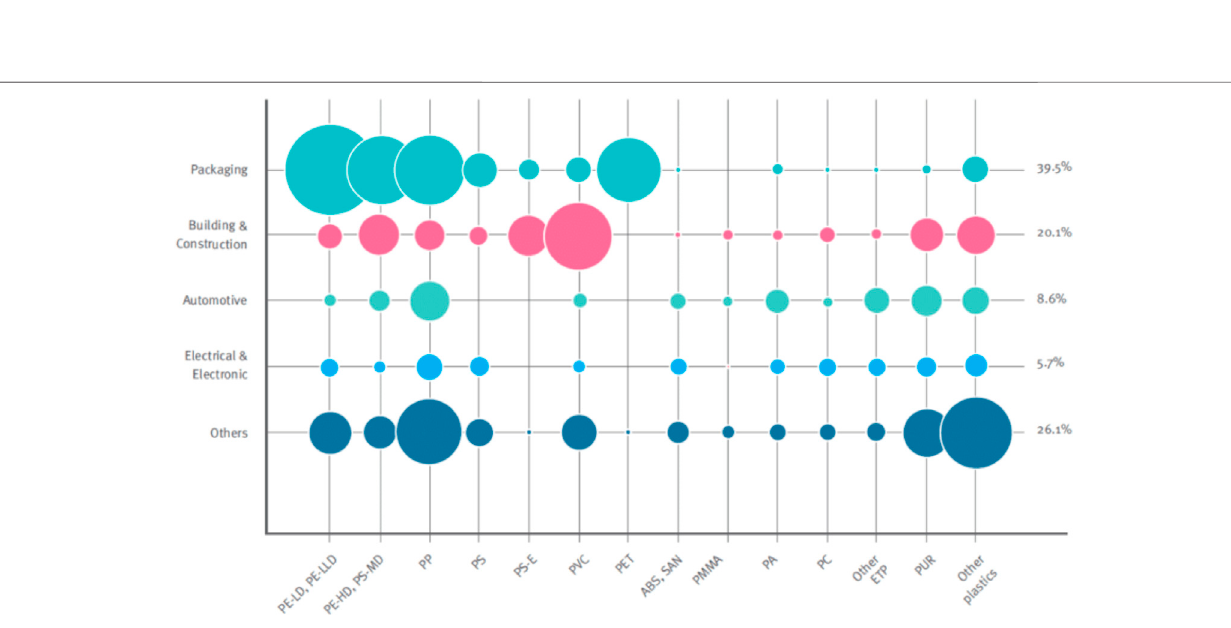
Frontiers in Environmental Science |